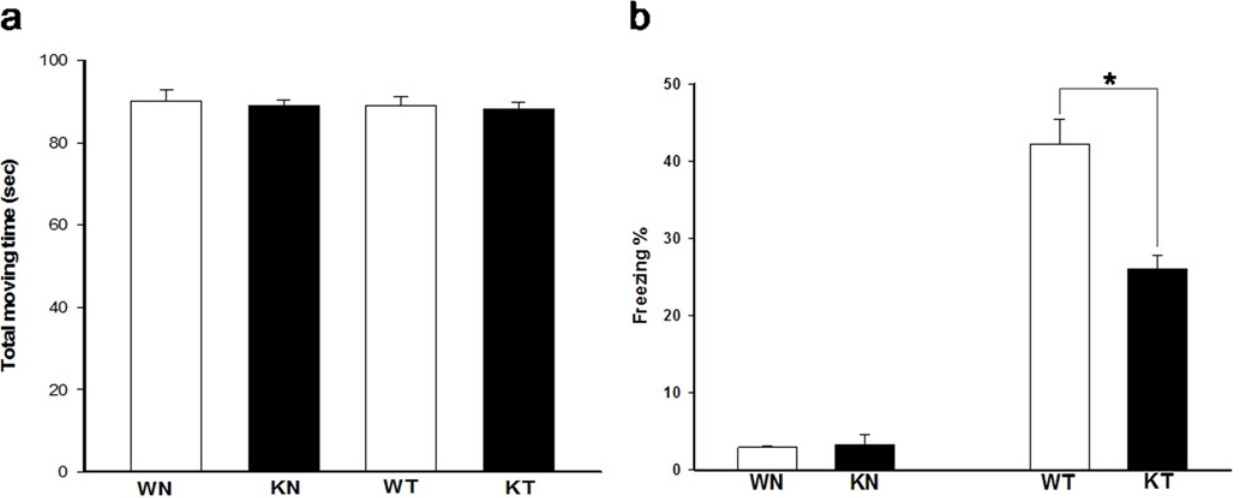
Fig 2. Behavioral analysis. (a) Locomotor activity for all groups measured during the first 120 seconds of the training protocol showed that the Ca v 3 . 2 knockout mice are as normal as their wild-type littermates. (b) The Ca v 3 . 2 knockout mice were impaired in retrieval of contextual memory tested 24 hours post the TFC training protocol. (WN: wild-type na ï ve group; KN: knockout na ï ve group; WT: wild-type training group; KT: knockout training group; * p < .05)